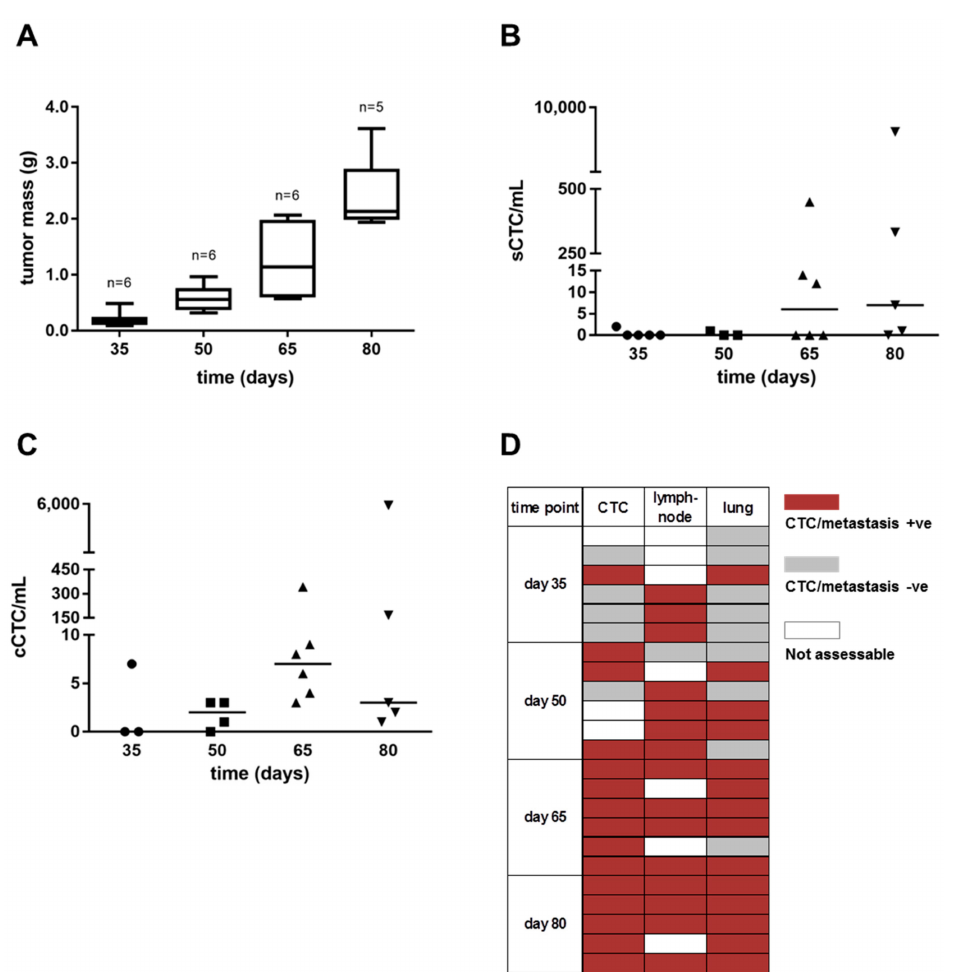
Figure 2. The detection of CTCs and metastases at the early and late stages of tumor progression in the MDA-MB-231 xenograft model. Box and whiskers plots and dot plots represent the distribution of ( A ) the total tumor mass, ( B ) single CTC (sCTC) and ( C ) CTC cluster or tumor microemboli (cCTC) numbers per milliliter of blood (horizontal line representing the median value), at di ff erent experimental time points. ( D ) the scheme represents the frequency of CTC-positive ( + ve) and of lymph-nodal or pulmonary metastasis-positive ( + ve) animals per group, at each experimental time